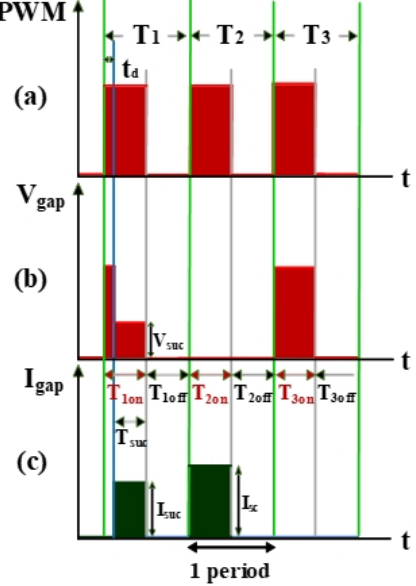
Figure 2. Waveforms of ( a ) pulse width modulation (PWM), ( b ) V gap , and ( c) I gap.